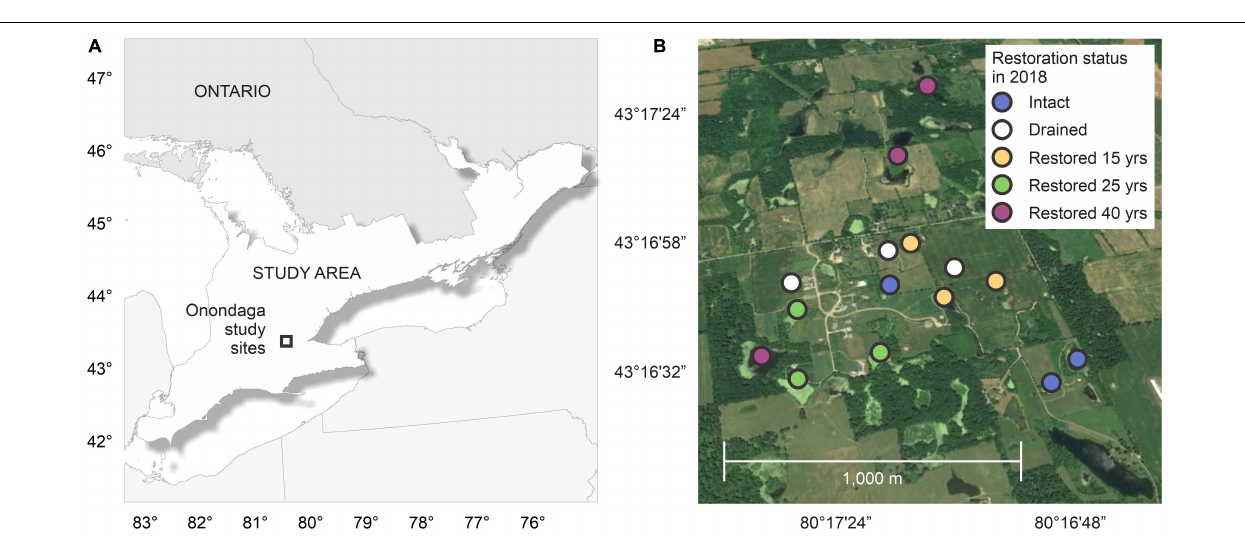
FIGURE 2 | Study area: (A) Location of Onondaga study sites. (B) Distribution of Onondaga study sites within the Fairchild Creek